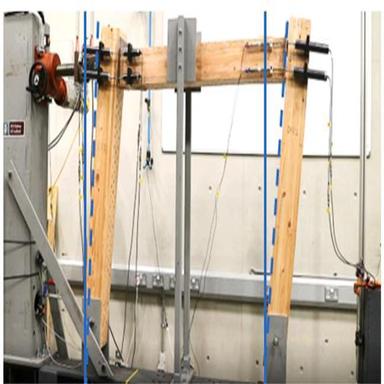
Typical deformation of frames.